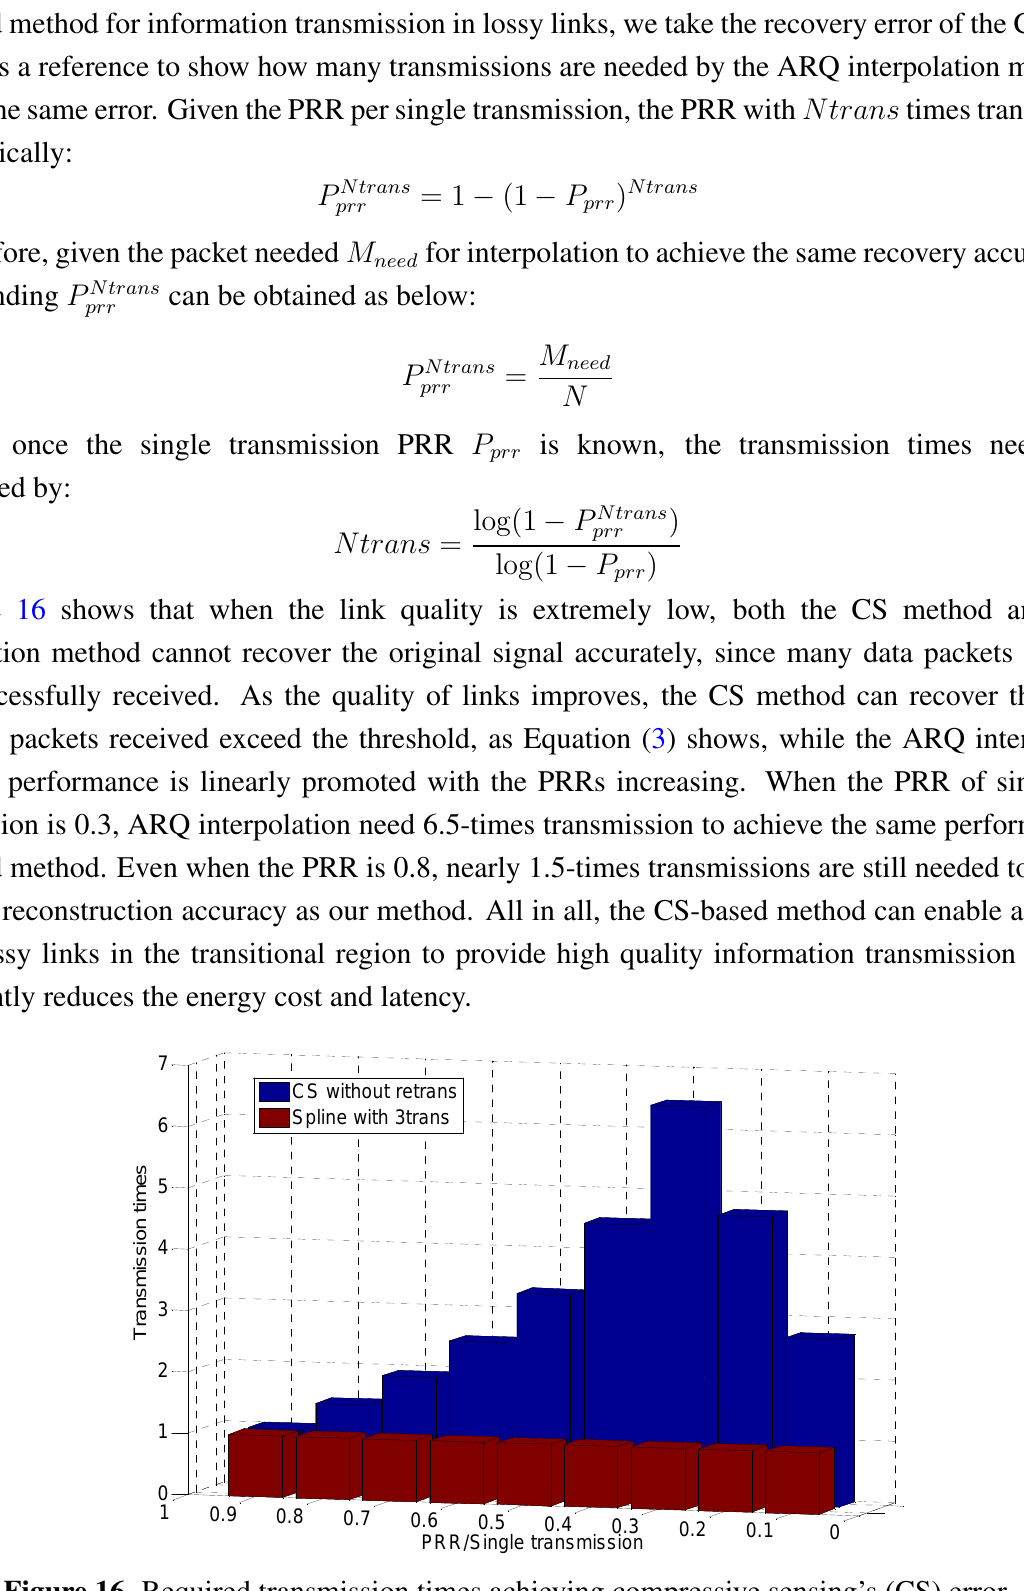
Figure 16. Required transmission times achieving compressive sensing’s (CS)